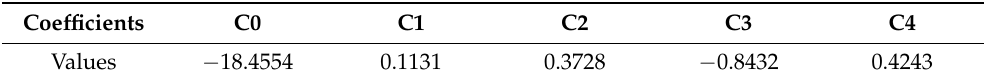
Table 5. Multiple regression coefficients for TEDI expressed by Equation